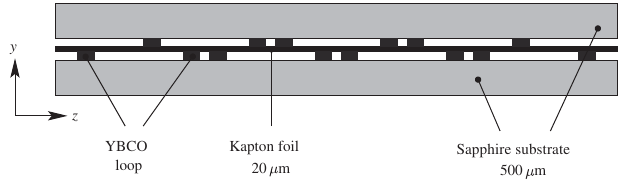
FIG. 3. Cut through the stacked induction-shimming structure with the substrate. The YBCO loops are arranged on a 500 (cid:3) m thick sapphire substrate. The thickness of the YBCO layer is 330 nm. The period of the mock-up is 14 mm.